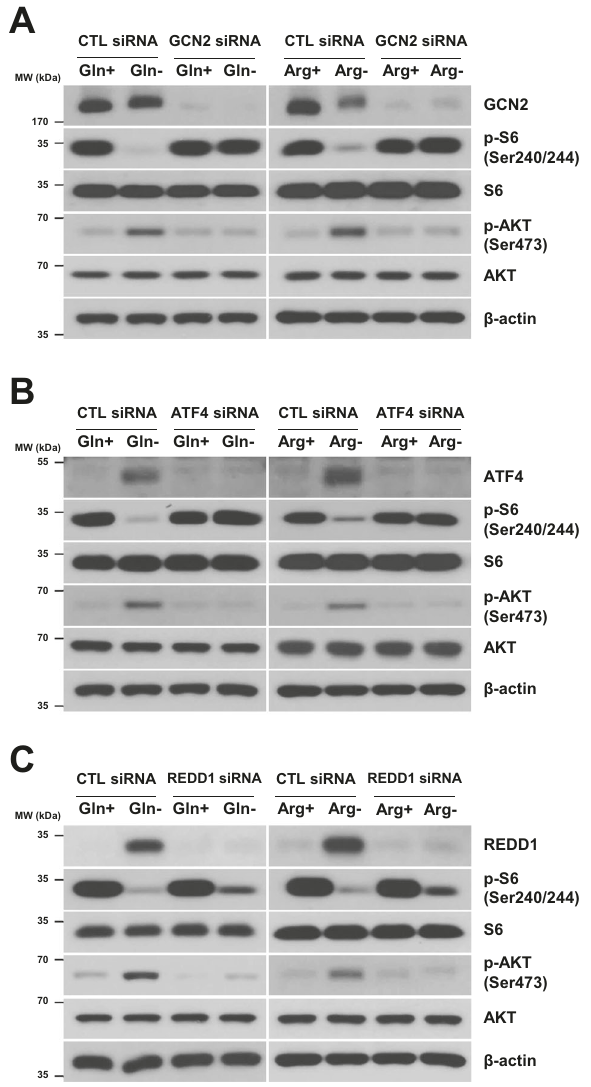
Fig. 4 The GCN2/ATF4/REDD1 signaling axis contributes to mTORC1 inhibition and mTORC2 activation upon the deprivation of glutamine or arginine. A – C H1299 cells were transfected with a control, GCN2, ATF4, or REDD1 siRNA for 12 h and then subjected to glutamine or arginine deprivation for 24 h. The levels of the indicated proteins were measured by western blot analysis. CTL: